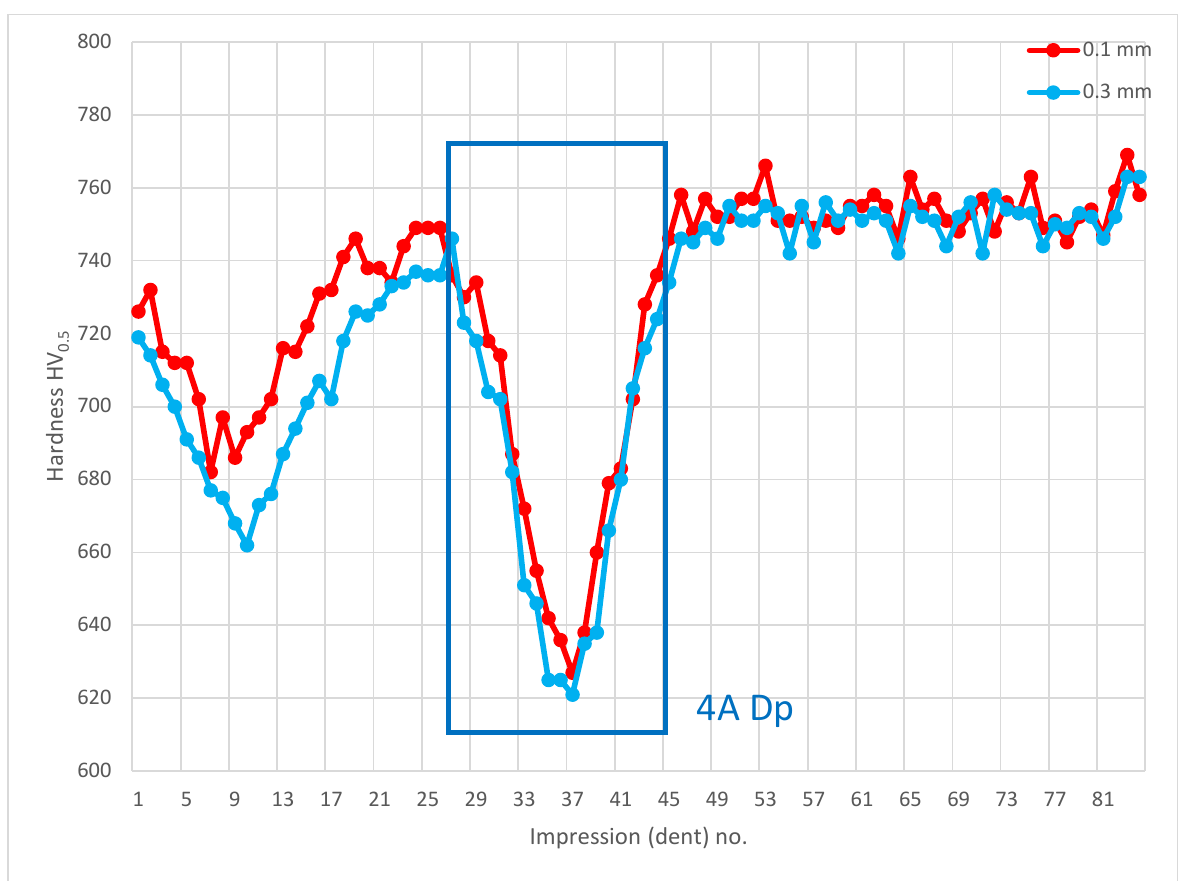
Figure 20. Microhardness measurement results. Paths depth (distance from tooth surface): 0.1 mm and 0.3 mm. Cross-section H-H, zone: 4A Dp.